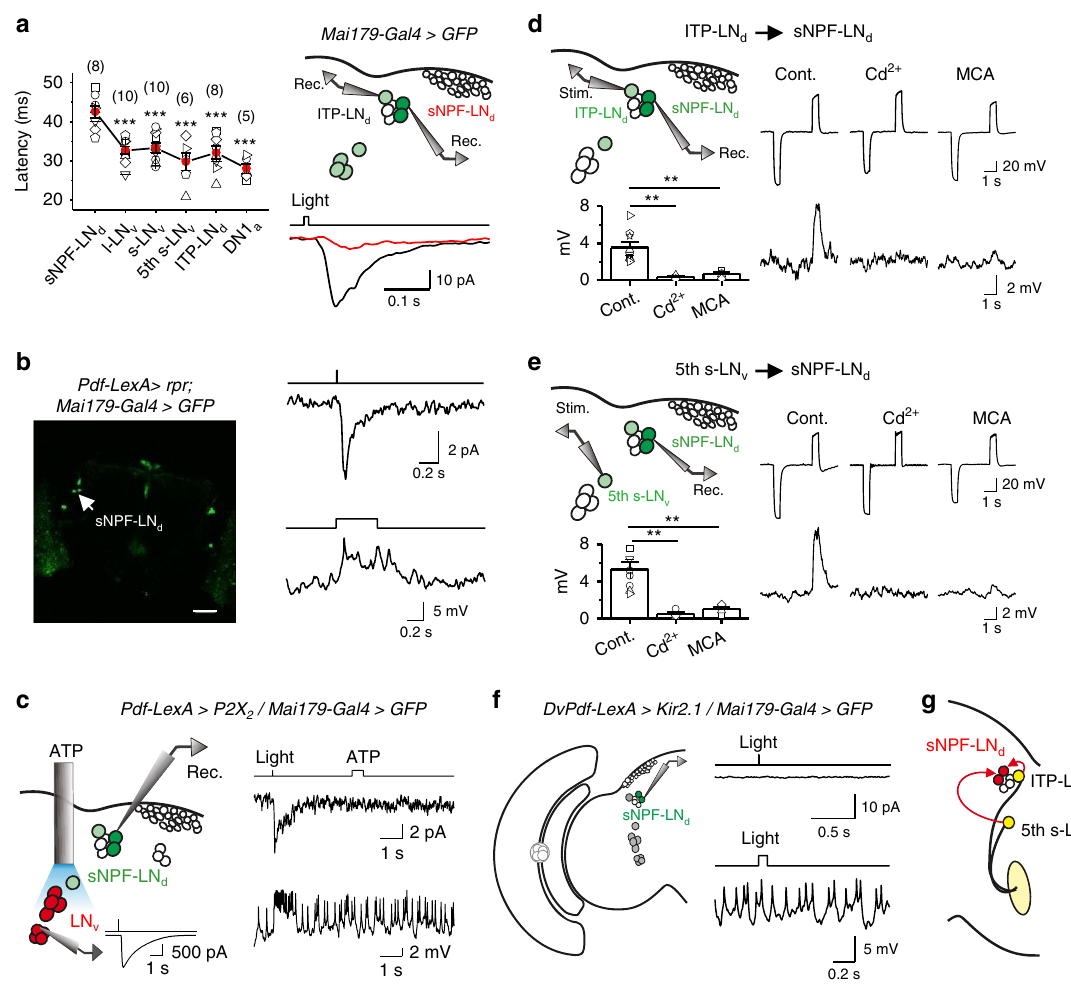
Fig. 5 sNPF-LNds receive inputs from the fi fth s-LNv and ITP-LNd cells. a sNPF-LNd responses have long latency. Left, average data. Right, dual patch- clamp recordings on pairs of sNPF-LNd and ITP-LNd (top) and their light responses (bottom). Light stimulation: 470 nm. Cell numbers are indicated in brackets; error bars represent SEM; *** P < 0.001 (comparison with sNPF-LNd). b PDF-expressing LNvs are not required for light responses of sNPF-LNds. Left, the LNvs are ablated by reaper . Scale bar: 50 μ m. Right, light responses (top, voltage clamp; bottom, current clamp) of sNPF-LNds remain intact in the absence of LNvs. The average response of 6.2 ± 0.8 pA ( n = 6, mean ± SEM) is not signi fi cantly different from the WT control of 6.6 ± 0.4 pA ( n = 4). c PDF-expressing LNvs do not excite sNPF-LNds. Left, scheme of simultaneous LNv activation and sNPF-LNd recordings. The LNvs expressing P2X 2 are activated by ATP, with a representative s-LNv response shown in the inset. Right, sNPF-LNds respond to light but not to LNv activation by ATP. ATP: 2.5 mM, 500 ms; light: 470 nm, 2 ms. The bar trace indicates the timing of ATP and light stimulations. Three out of three sNPF-LNd recordings show no ATP responses. d sNPF-LNds receive inputs from the ITP-LNd. Left, scheme of dual patch-clamp recordings (top) and average sNPF-LNd responses (bottom). Right, ITP-LNd stimulation triggers sNPF-LNd responses. n = 9, 4, and 4 for control, 100 μ M Cd 2 + , and 50 μ M MCA, respectively; error bars represent SEM; ** P < 0.01. e sNPF-LNds receive inputs from the fi fth s-LNv. Left, scheme of dual patch-clamp recordings (top) and average sNPF-LNd responses (bottom). Right, fi fth s-LNv stimulation triggers sNPF-LNd responses. n = 8, 4, and 4 for control, 100 μ M Cd 2 + , and 50 μ M MCA, respectively; error bars represent SEM; ** P < 0.01. f The fi fth s-LNv and ITP-LNd are required for sNPF-LNd light responses. Left, illustration of sNPF-LNd recordings when the fi fth s-LNv and ITP-LNd are silenced by Kir2.1 . Right, current (top) and voltage (bottom) responses of sNPF-LNds to light stimulation. Five out of fi ve recordings show no light responses. g Schematic illustration of visual inputs from the fi fth s-LNv and ITP-LNd to